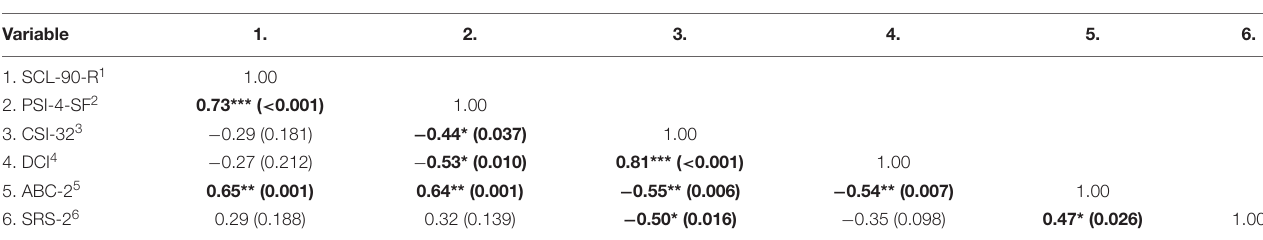
TABLE 11 | Pearson correlations for maternal variables ( n = 23).